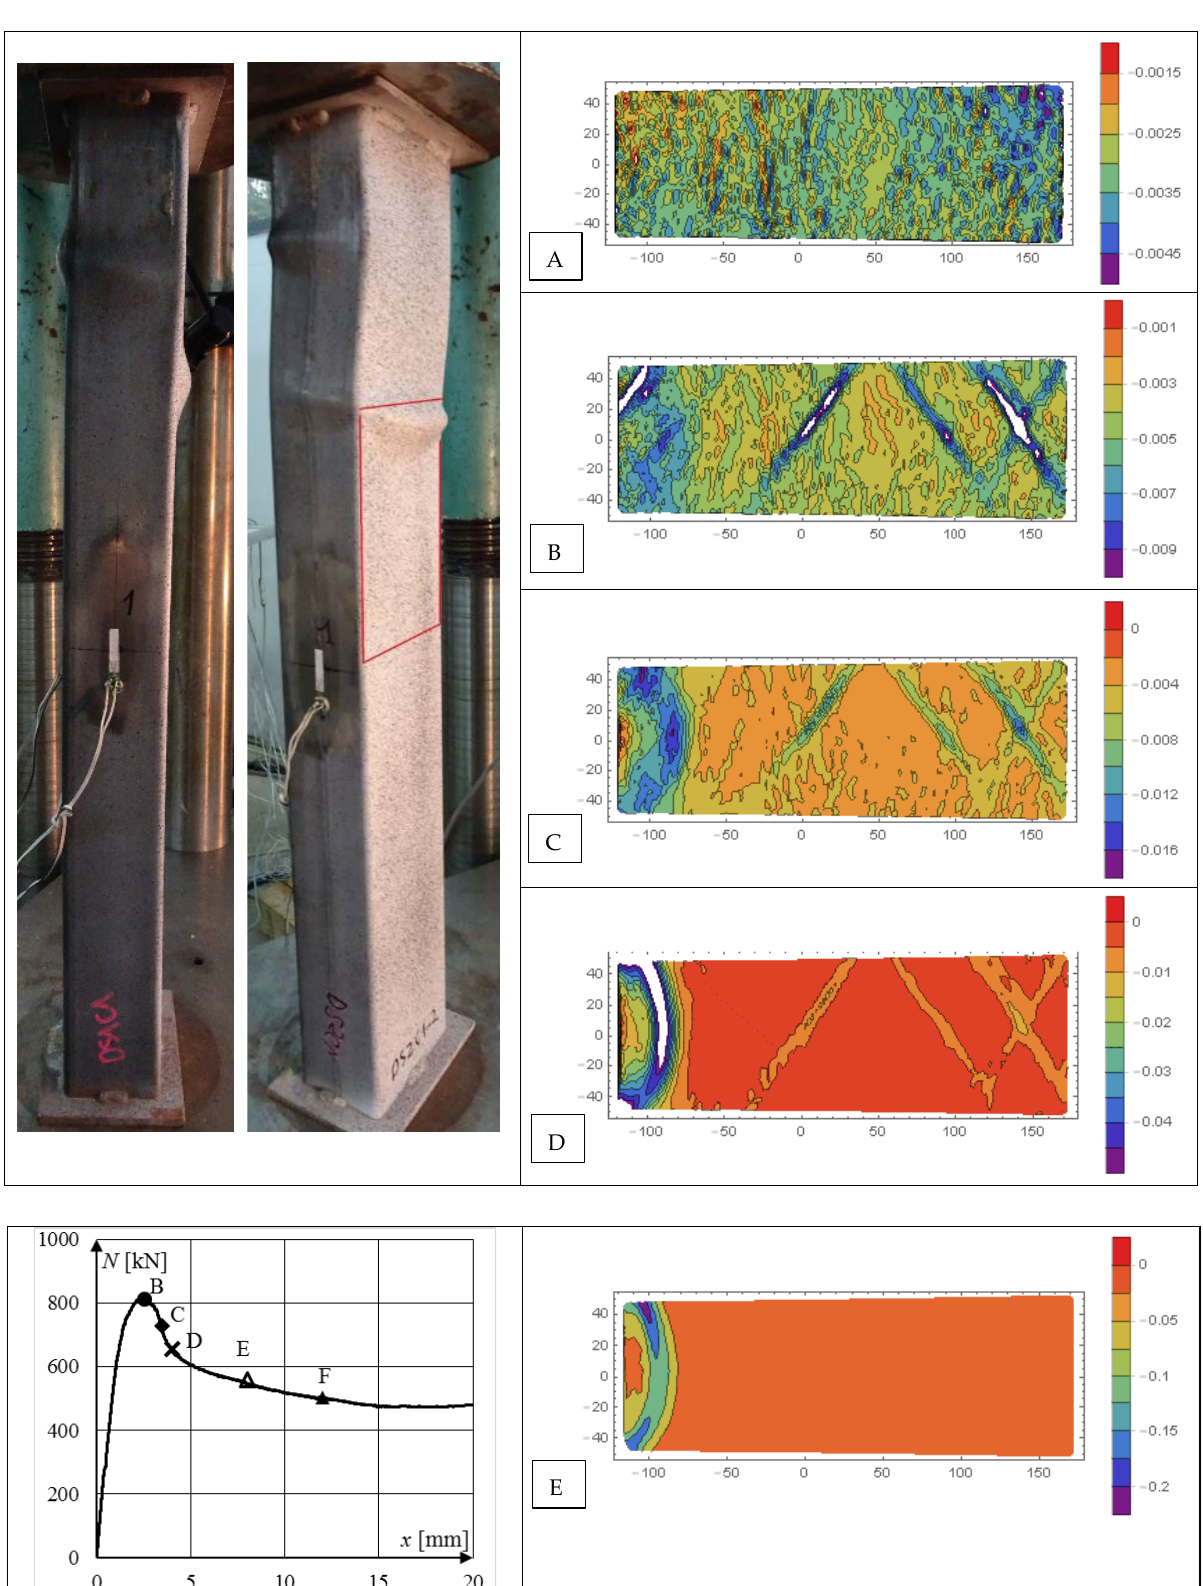
Figure 18. Evolution of strains ε xx in column DS1C2_1, steel S235, stronger concrete, ξ = 0.90.Points ( A , B ) indicate strains before reaching the ultimate load and when the maximum force was reached, respectively. Points ( C – E ) mark selected places in the post-peak part of the equilibrium path.